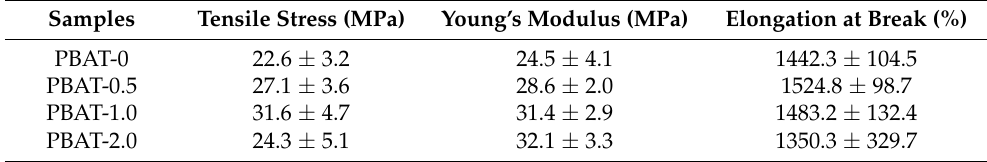
Table 3. Tensile properties of PBAT/Ti 3 C 2 T X nanocomposite casting